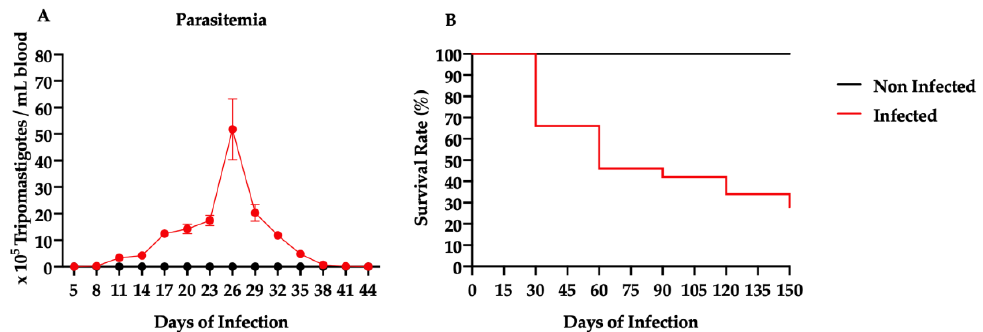
Figure 2. Parasitemia and survival of CD1 mice ( A ) The number of parasites ( × 10 5 ) per mL of blood versus days after infection progress. ( B ) Kaplan–Meier curve showing survival of infected mice with T. cruzi (Brazil strain) and non-infected animals until 150 days post-infection (dpi). Mice in the infected group showed a survival rate of 28%. None of the non-infected mice died.